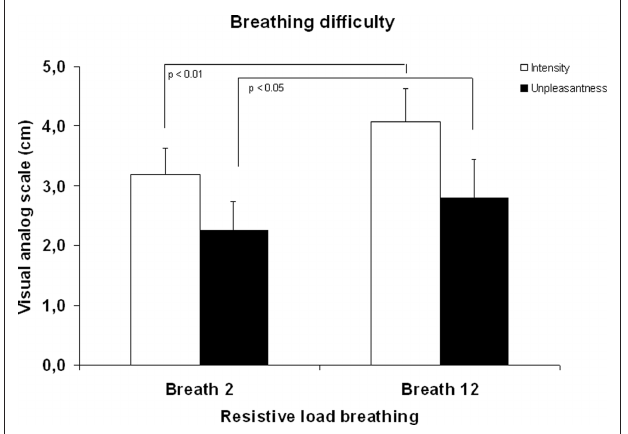
FiGurE 2 | Group means for the respiratory-related evoked potential and related scalp topographies (at their peak latencies) at centro-parietal regions.FiGurE 1 | Mean (SE) ratings of perceived intensity and unpleasantness